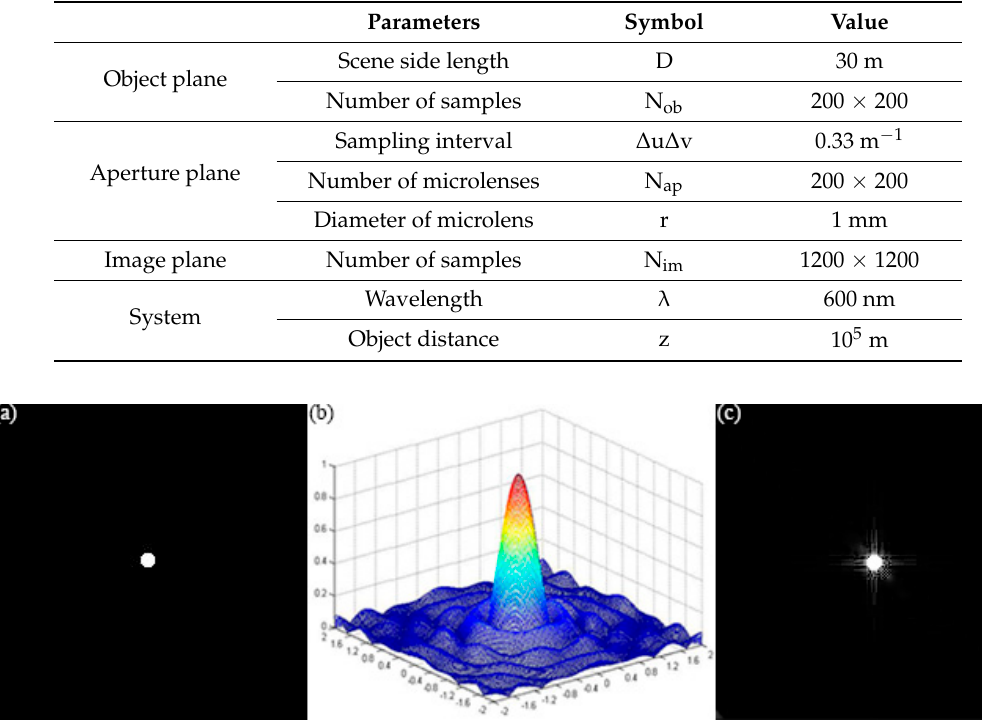
Table 1. Simulation parameters of the imaging system.